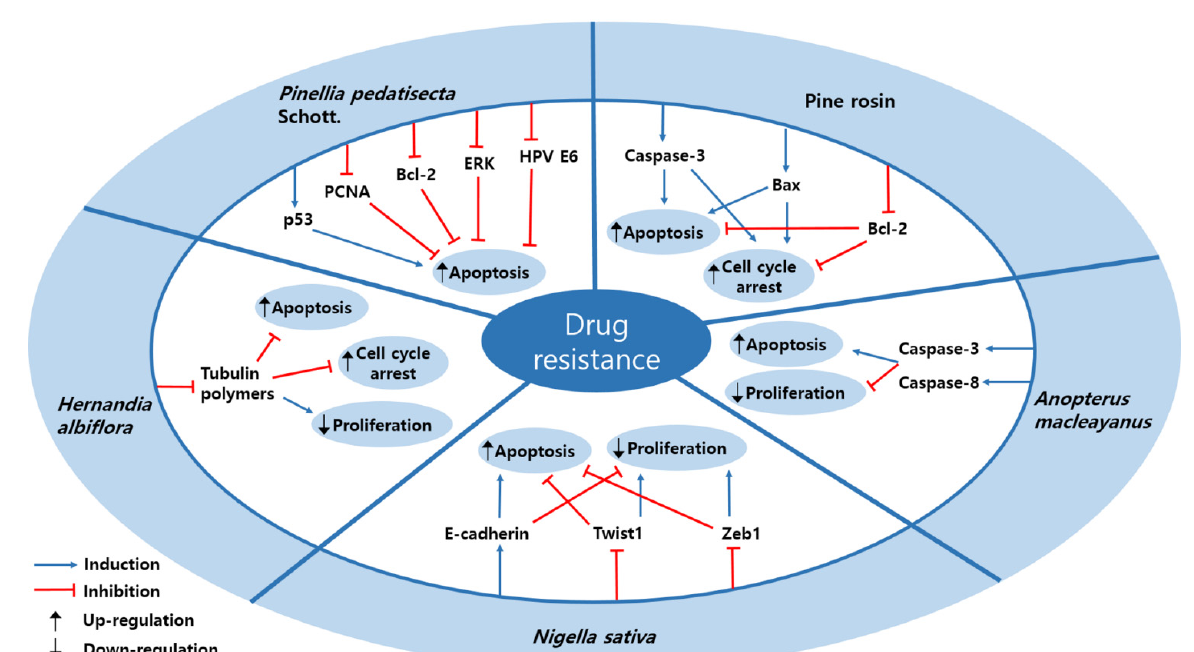
Figure 3. Schematic diagram of drugs resistance signal pathways regulated by natural products in cervical cancer.